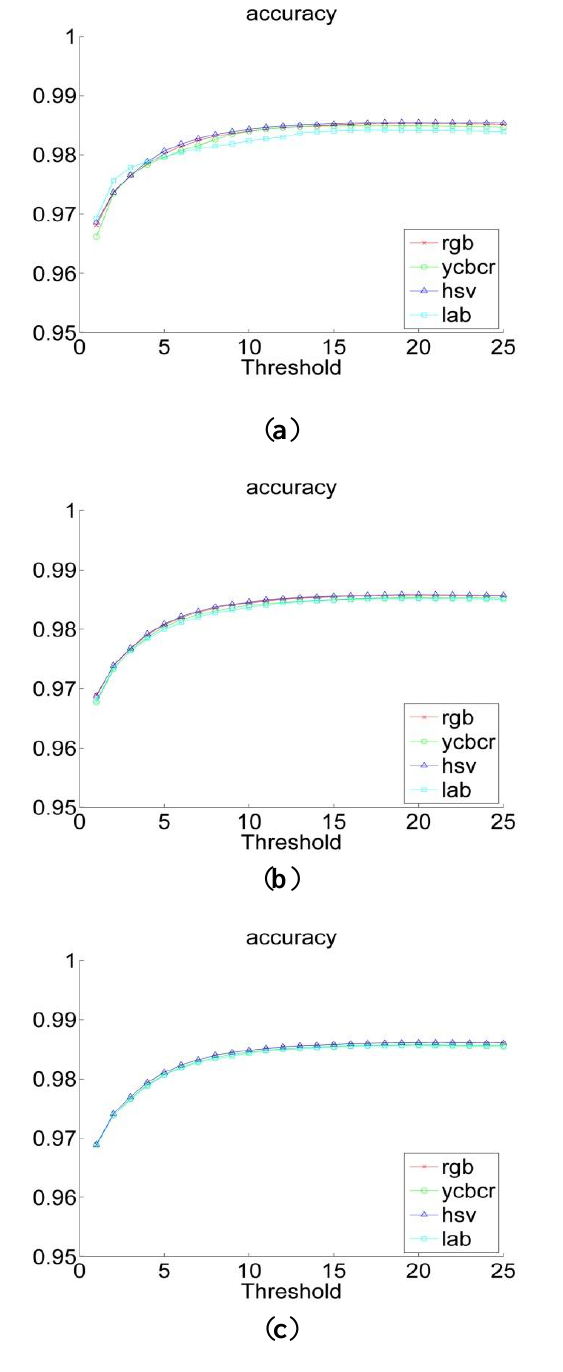
Figure 7. The accuracy performance of the color spaces for a histogram resolution of ( a ) 64 bins; ( b ) 128 bins and ( c ) 256